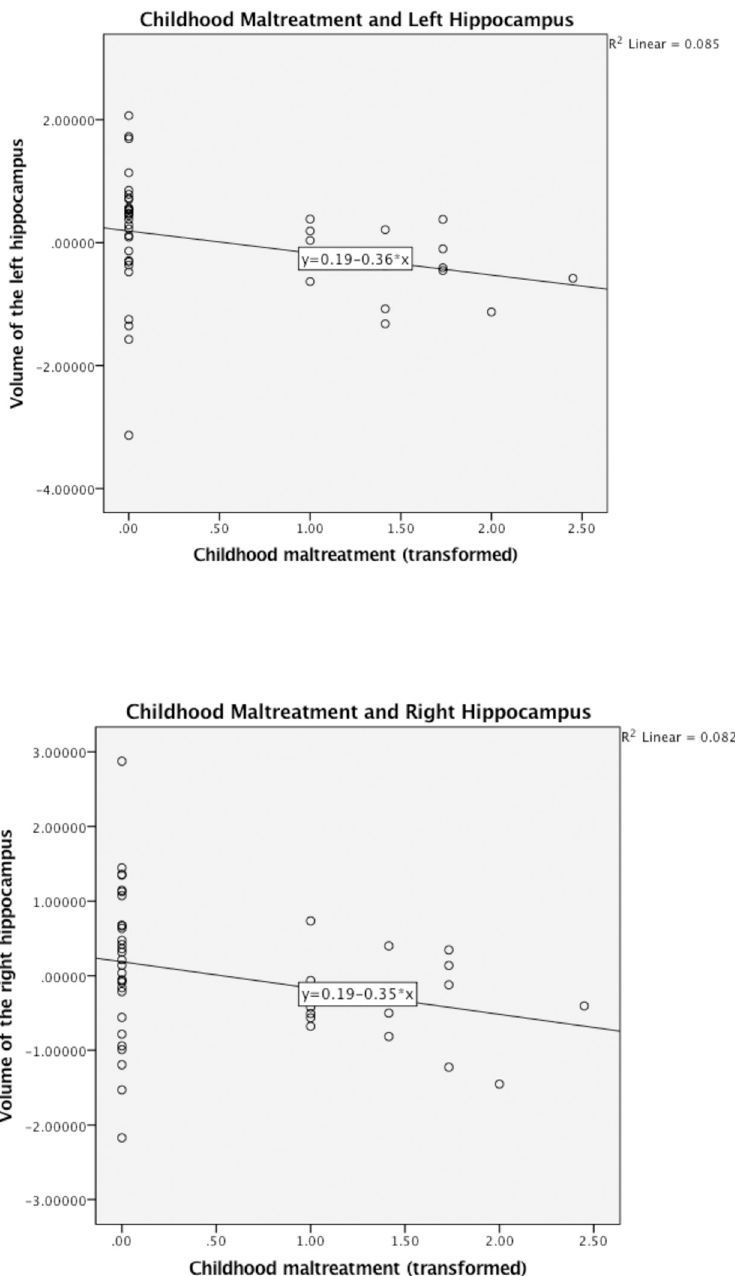
Fig 1. Hippocampal volume as a function of childhood maltreatment, adjusted for childhood SES, current SES, recent negative interpersonal events, sex, age, total brain volume, and BMI.